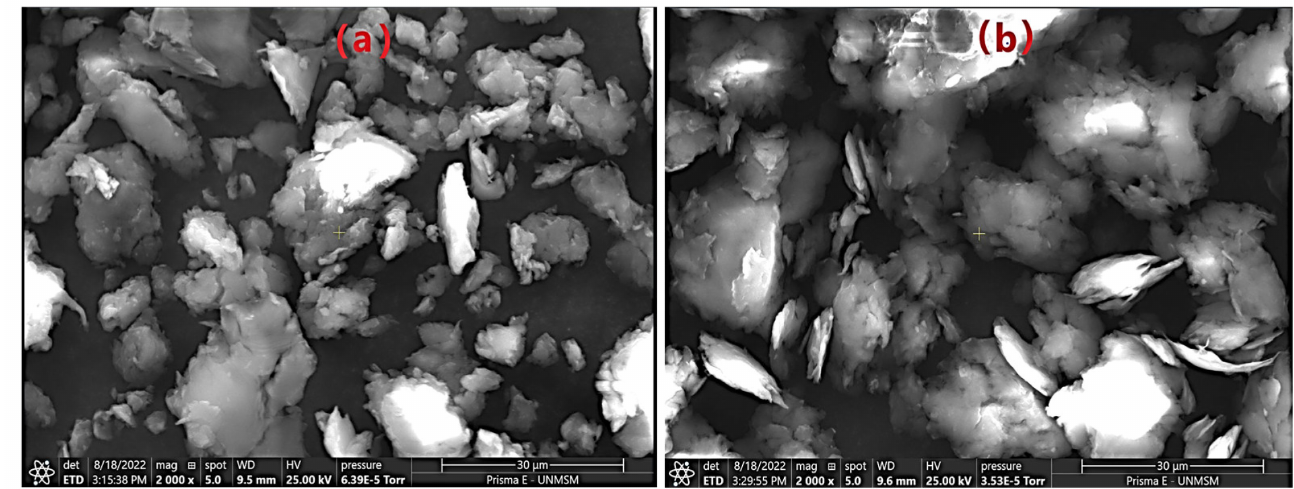
Figure 3. SEM images ( a ) cellulose, ( b ) NCCA.